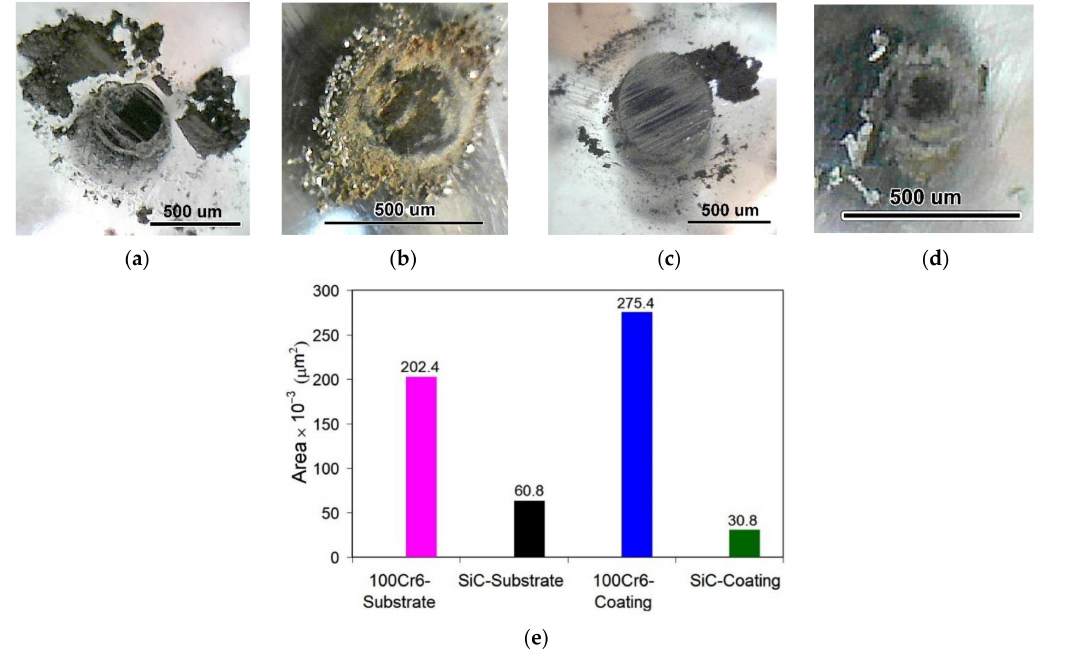
Figure 13. Worn surface of the counter balls: ( a ) 100Cr6-substrate (steel of AISI 4145H grade), ( b ) SiC- substrate (steel of AISI 4145H grade), ( c ) 100Cr6-coating, ( d ) SiC-coating.( e ) Mean surface area of the wear spot on the ball after sliding